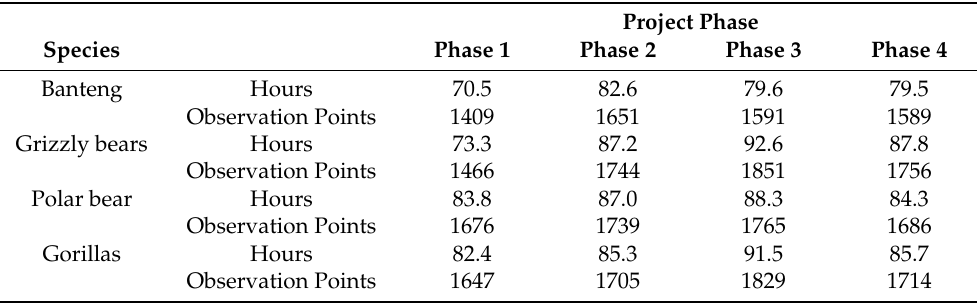
Table 3. Total number of hours observed (out of 96 possible hours) and observation points (out of 1920 possible data points) per species for each